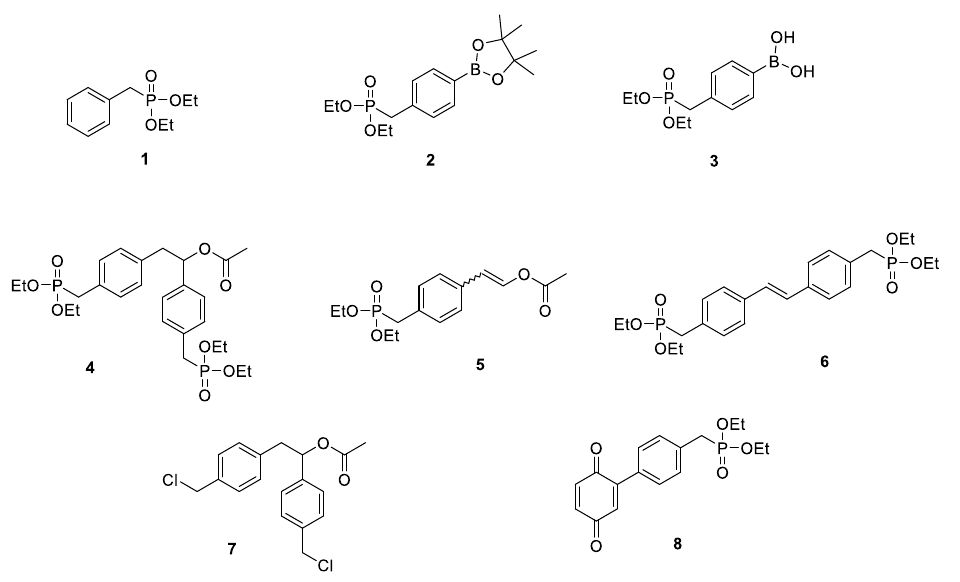
Figure 2. The structures of studied compounds.